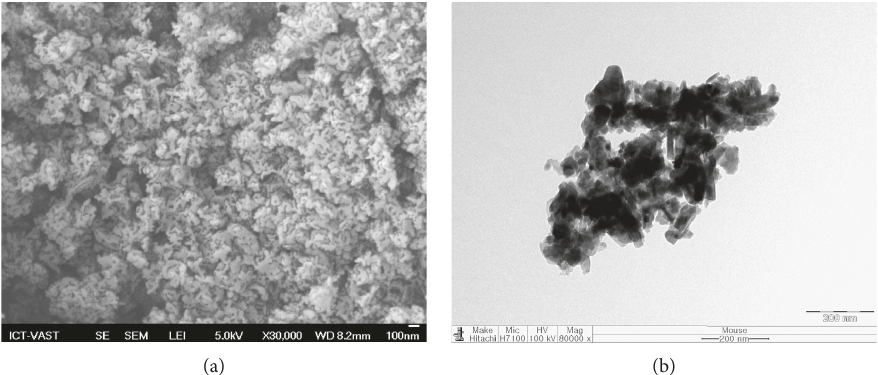
Figure 4: SEM images (a) and TEM image (b) of Li